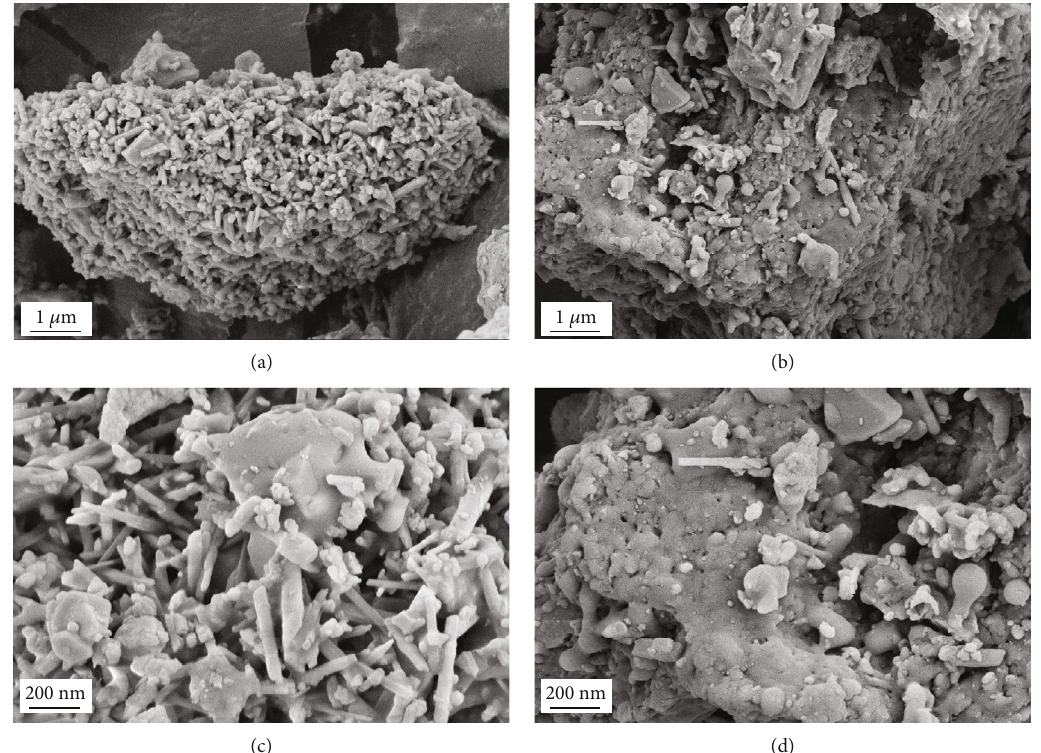
Figure 3: (a, b) Low-magni fi cation (25.00 KX) and (c, d) high-magni fi cation (50.00 KX) SEM images of RR-B and RR-C, respectively.